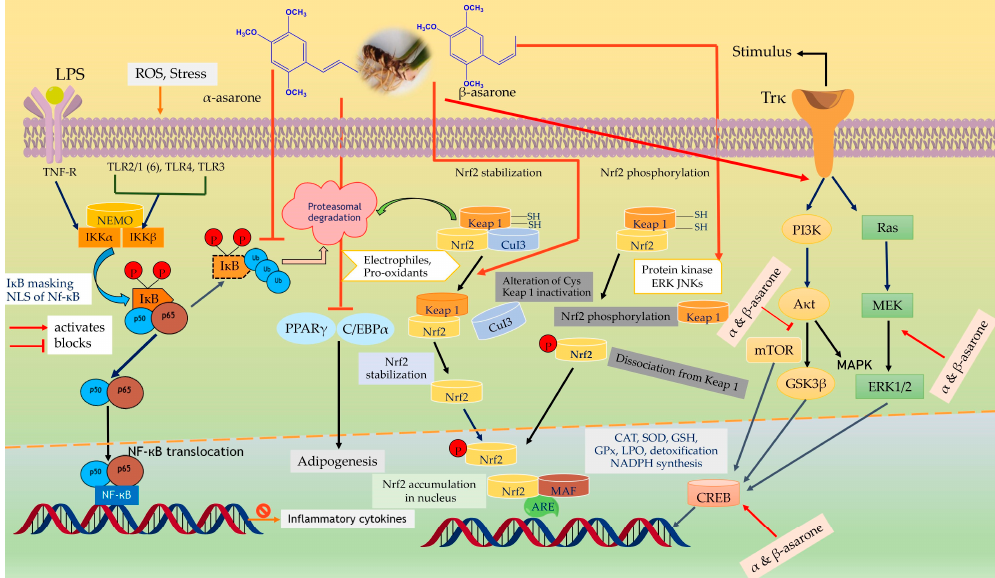
Figure7. TheroleoftheNrf-2, NF- κ B,PI3K / AKT,Ras / MAPK,andPPAR γ signalingpathwaysasa ff